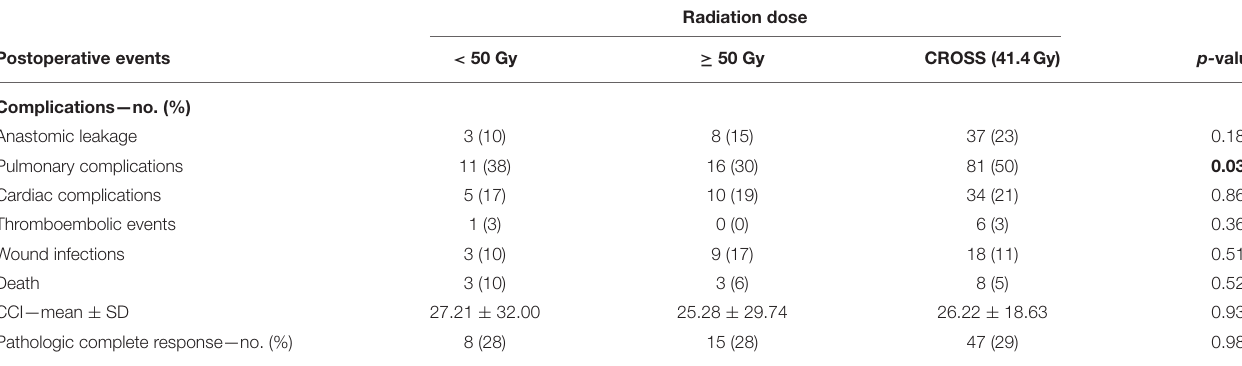
TABLE 3 | Comparison to post-operative events in CROSS study group data.